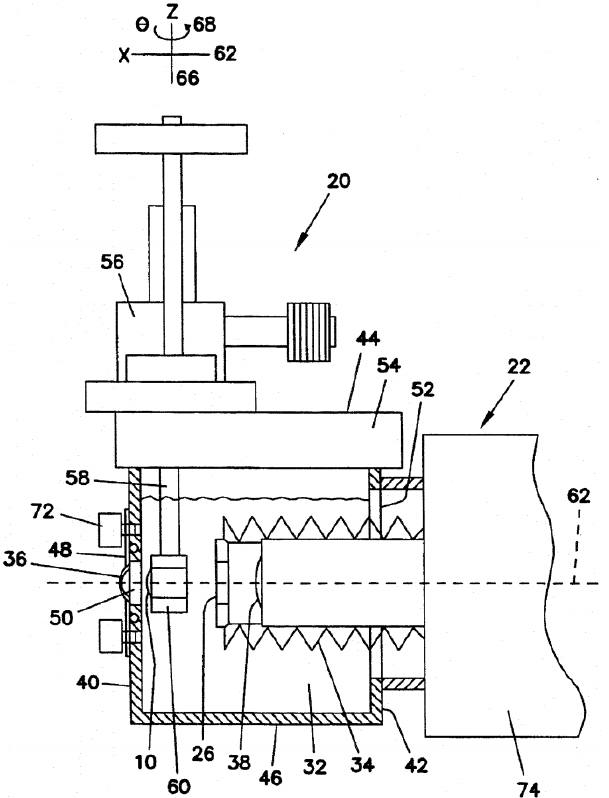
Figure 10. Drawings of the device described in Schneider and Keates. Originally published by and reprinted from U.S. Patent 5,652,640, 29 July 1997 ([74]).